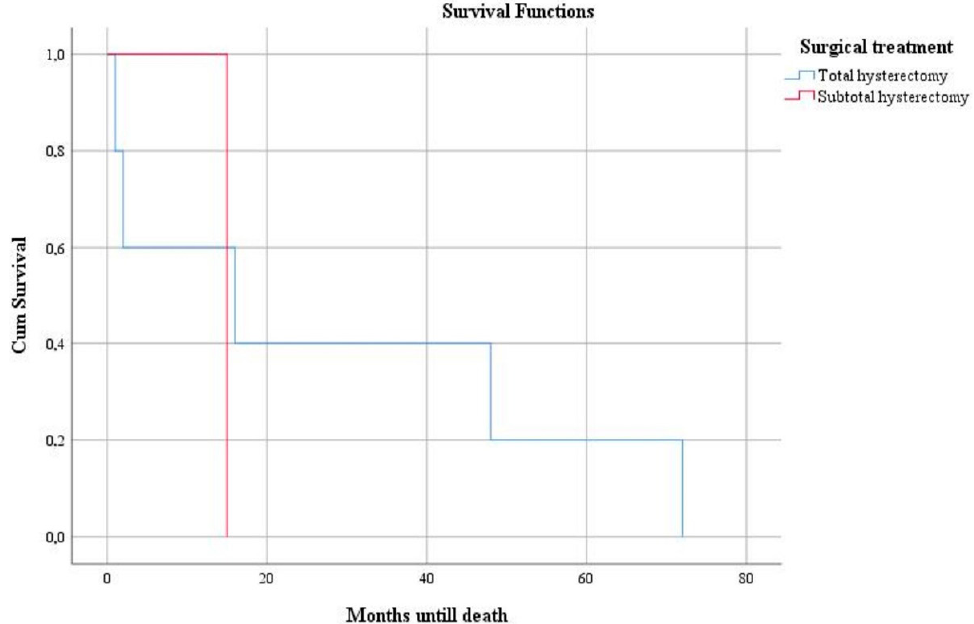
Figure 4. Correlations of the number of CD8 positive T cells with: ( a ) hormonal status; ( b ) diabetes mellitus; ( c ) thyroid function; ( d ) atypia.